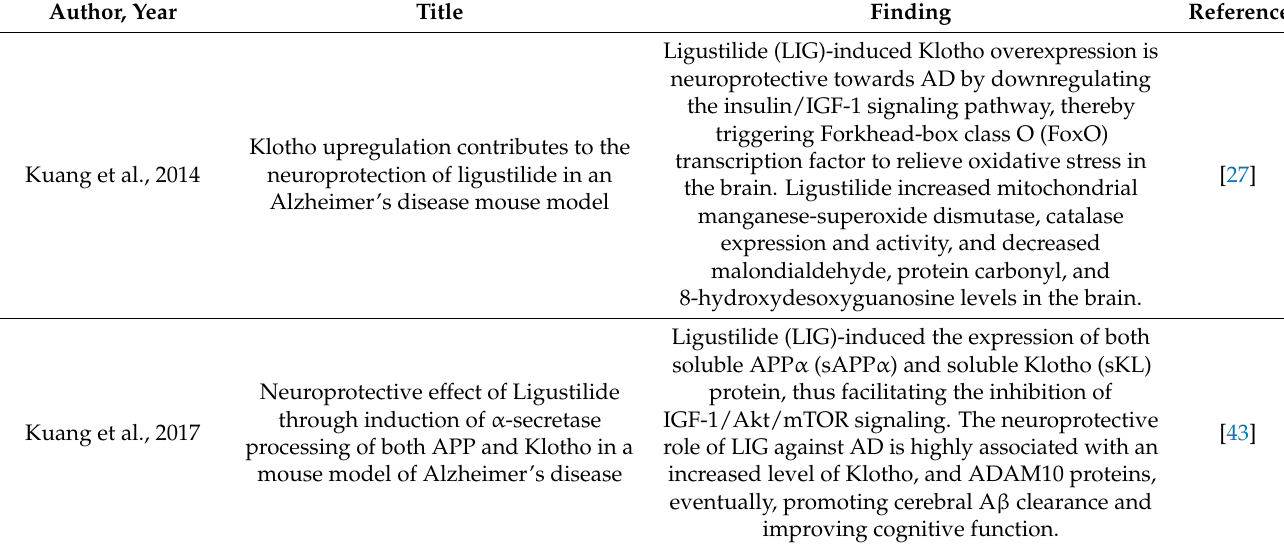
Table 1. Recent works on Klotho protein in Alzheimer’s disease